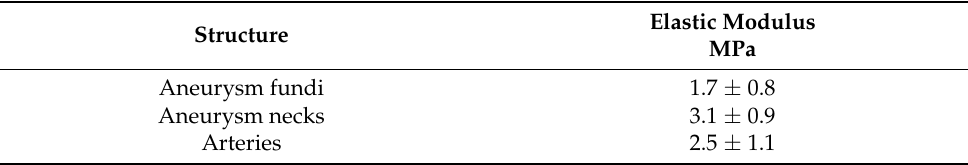
Table 4. Average mechanical data from in vitro studies on CA specimens evaluated by uniaxial strain/stress measurements